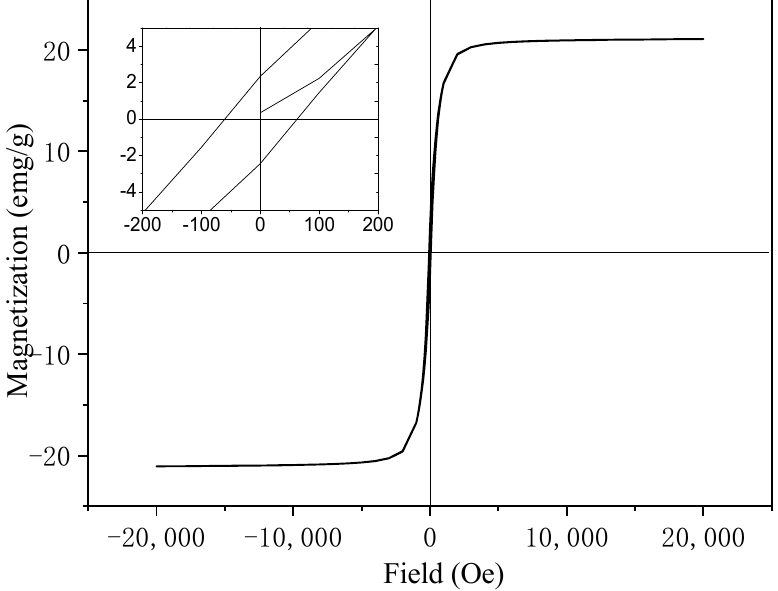
Figure 4. Magnetization hysteresis (M-H) loops measured at 300 K (the inset is a partially enlarged image of the curve).